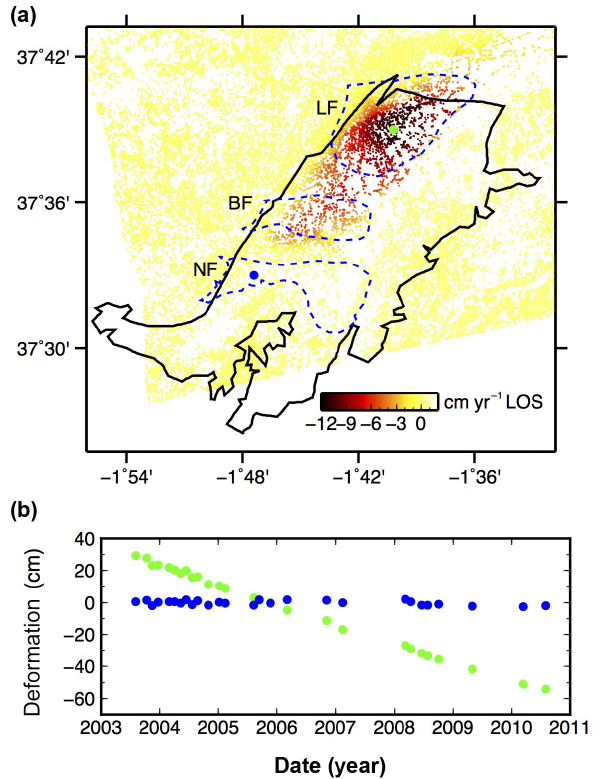
Figure 10. (a) Map showing ground deformation over the Alto Guadalentín aquifer (delineated by the solid black line). The dashed blue lines indicate the location of the three fans shown in Fig. 1b (LF: Lorca fan, BF: Béjar fan and NF: Nogalte fan). (b) Tempo- ral evolution of deformation for two locations in the study region. Green points represent deformation for the location of the green point in (a) , and blue points represent deformation for the location of the blue point in (a)